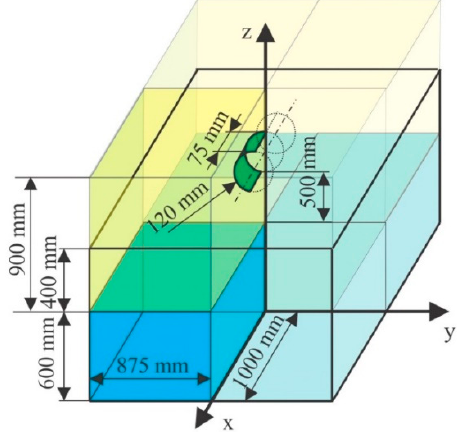
Figure 1. Geometrical configuration, dimensions, and symmetries.